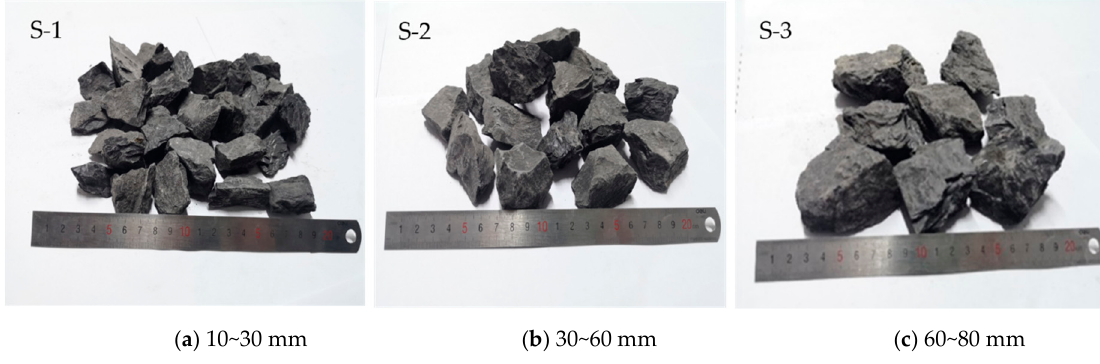
Figure 4. Crushed mudstone samples for the tests.